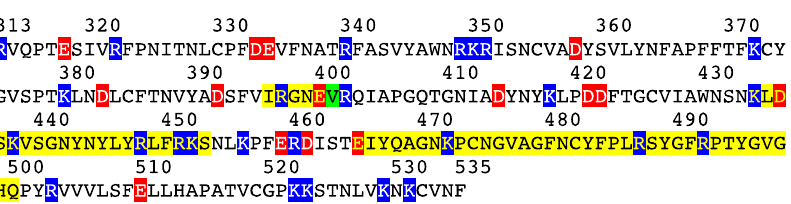
Figure 5. Amino acid sequences of RBDs from omicron BA.1 lineage, omicron BA.2 lineage and omicron BA.3 lineage. Electropositively (K,R) and electronegatively (D,E) charged amino acids are highlighted in blue and red, respectively. Loop regions of the RBDs from the omicron spike protein, which participate in the interaction with ACE2 receptor, are highlighted in yellow. Amino acid changes correspond to charged residues and hydrophobic residues are highlighted in black and green, respectively. Net charge and calculated isolectric point ( p I) values are indicated for RBD from each omicron BA.1, omicron-BA.2 and omicron BA.3 lineages. In spite of the amino acid changes that occurred in the RBDs and in other regions of the spike protein (37, 31 and 33 point mutations occurred in omicron BA.1, BA.2 and BA.3 lineages, respectively, compared to the sequence from the Wuhan wt of SARS-CoV-2 [14,18,19]), both the net charges and calculated isoelectric points of the omicron BA.1 (10 and 9.16) and BA.2 (10, 9.17) lineages remain closely similar. However, some discrepancy